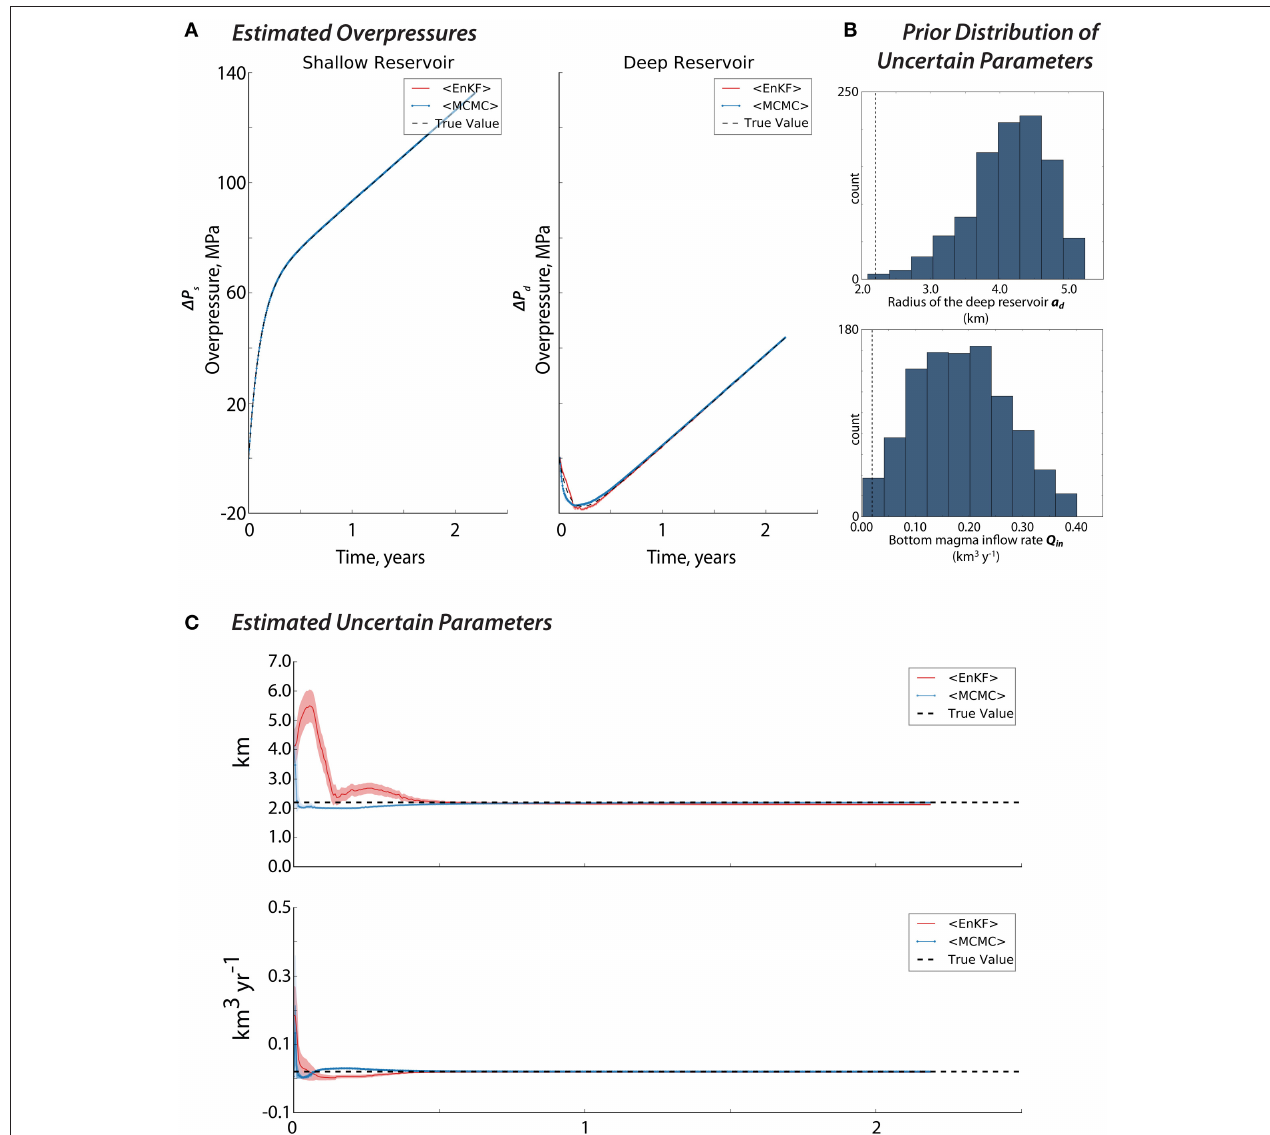
FIGURE 14 | Comparison between the EnKF-estimated and MCMC-estimated (A) overpressures and (C) uncertain model parameters given the prior distributions of a d and Qin in (B) . For the two techniques, we used 80 synthetic observations (i.e., combined radial and vertical displacements) located uniformly, every 100 m, at r 1 4.9 km and are available every time-step. The light blue and pink shades represent the spread (1 σ ) of the estimation. The true values are the black broken lines. = −